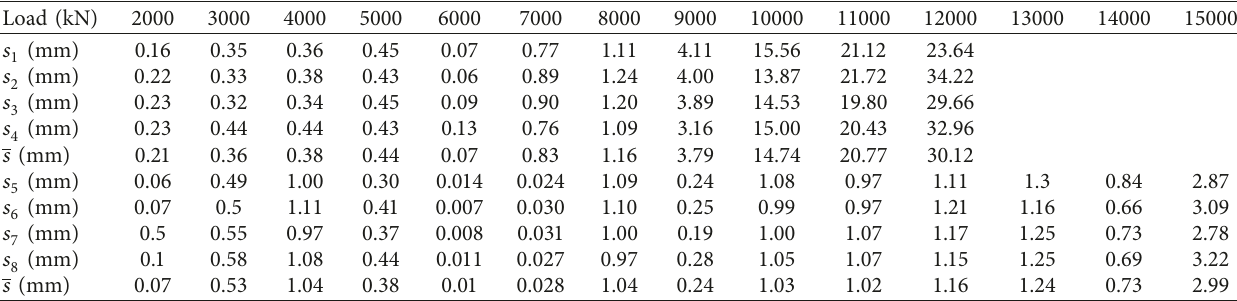
Figure 4: (a) The distributions of soil and the spacing of stress gauges along the pile shaft. (b) Anchor pile beam counterforce device consisting of (i) hydraulic jack, (ii) automatic displacement acquisition instrument, anchor bar, main beam, secondary beam, and reference beam. Table 2: Settlement of two piles measured under various